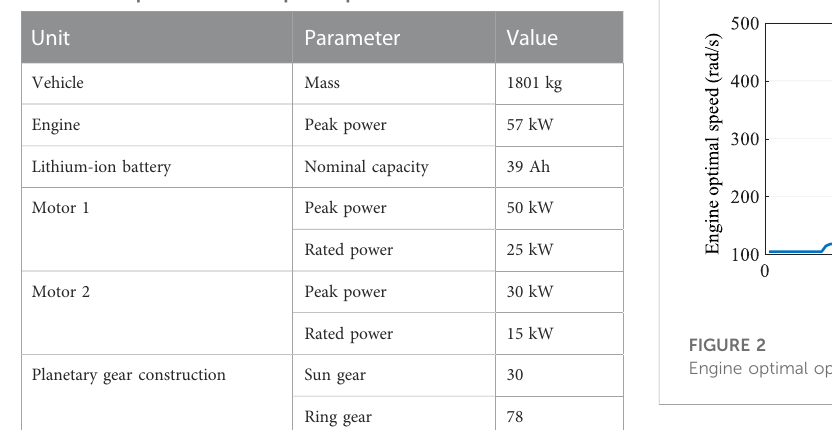
TABLE 1 Main parameters of the power-split PHEV.